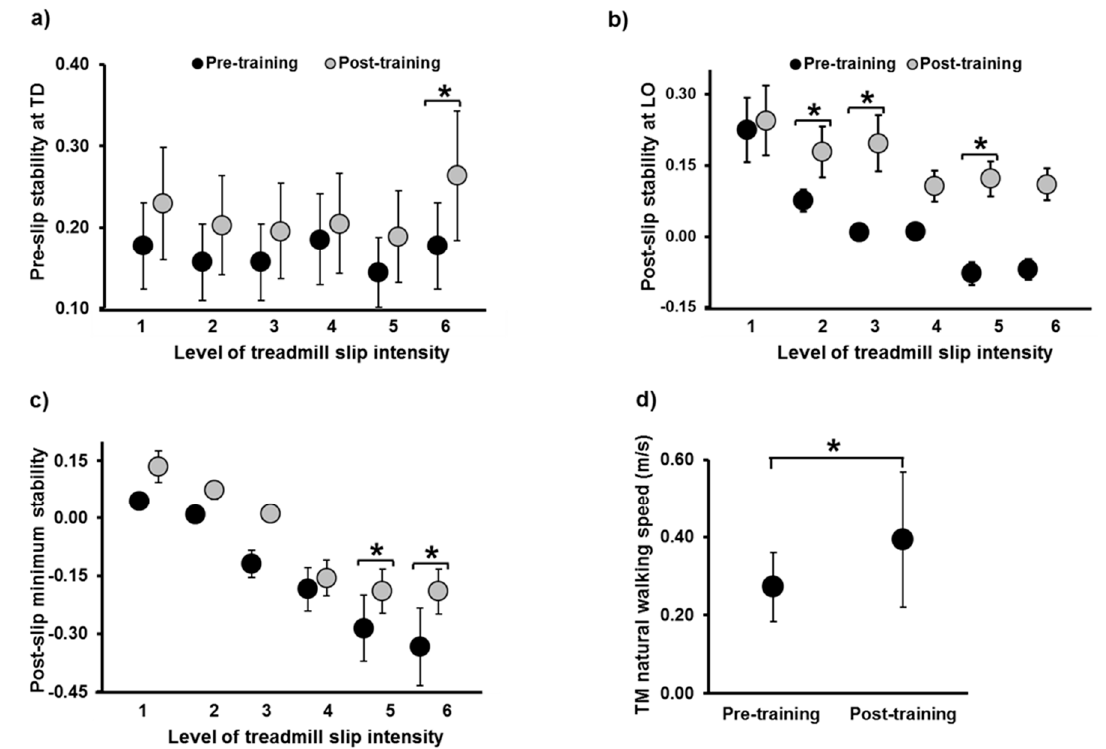
Figure 4. Figure showing ( a ) pre-slip stability at touch down (TD), ( b ) post-slip stability at lift-off (LO), and ( c ) post-slip